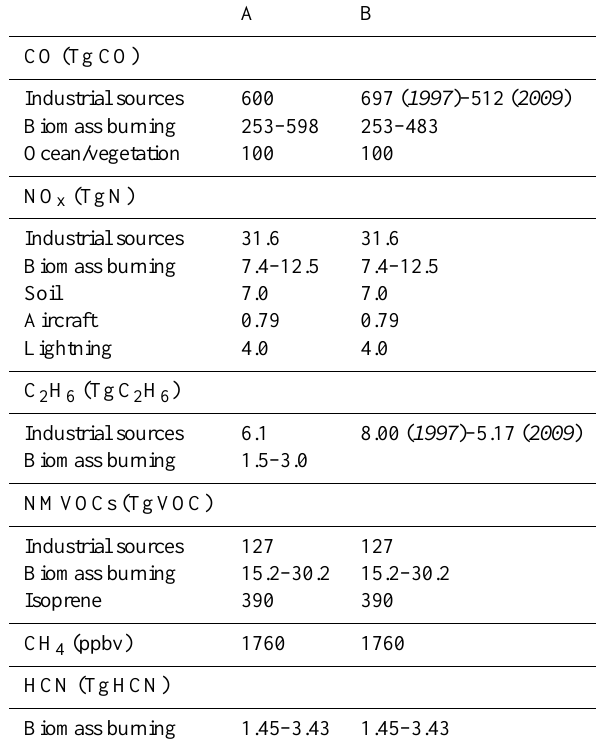
Table 1. Summary of annual total